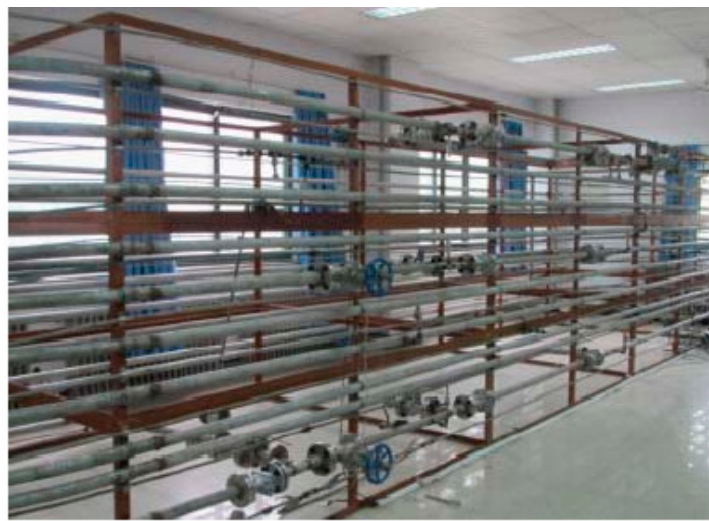
Figure 7. Diagram of the test loop with a 42 mm pipe diameter.